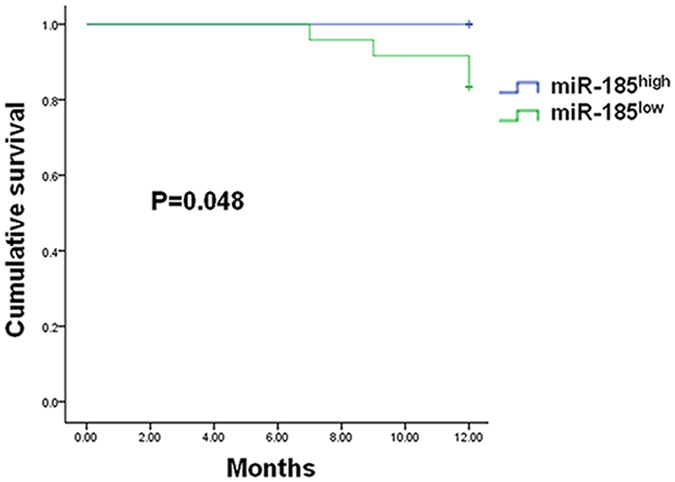
Kaplan-Meier Survival Curves for MiR-185high and MiR-185low Patients.